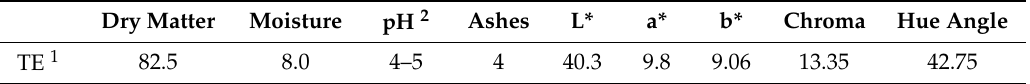
Table 1. Tannin extract (TE) composition (%) and instrumental color. Dry Matter Moisture pH 2 Ashes L*